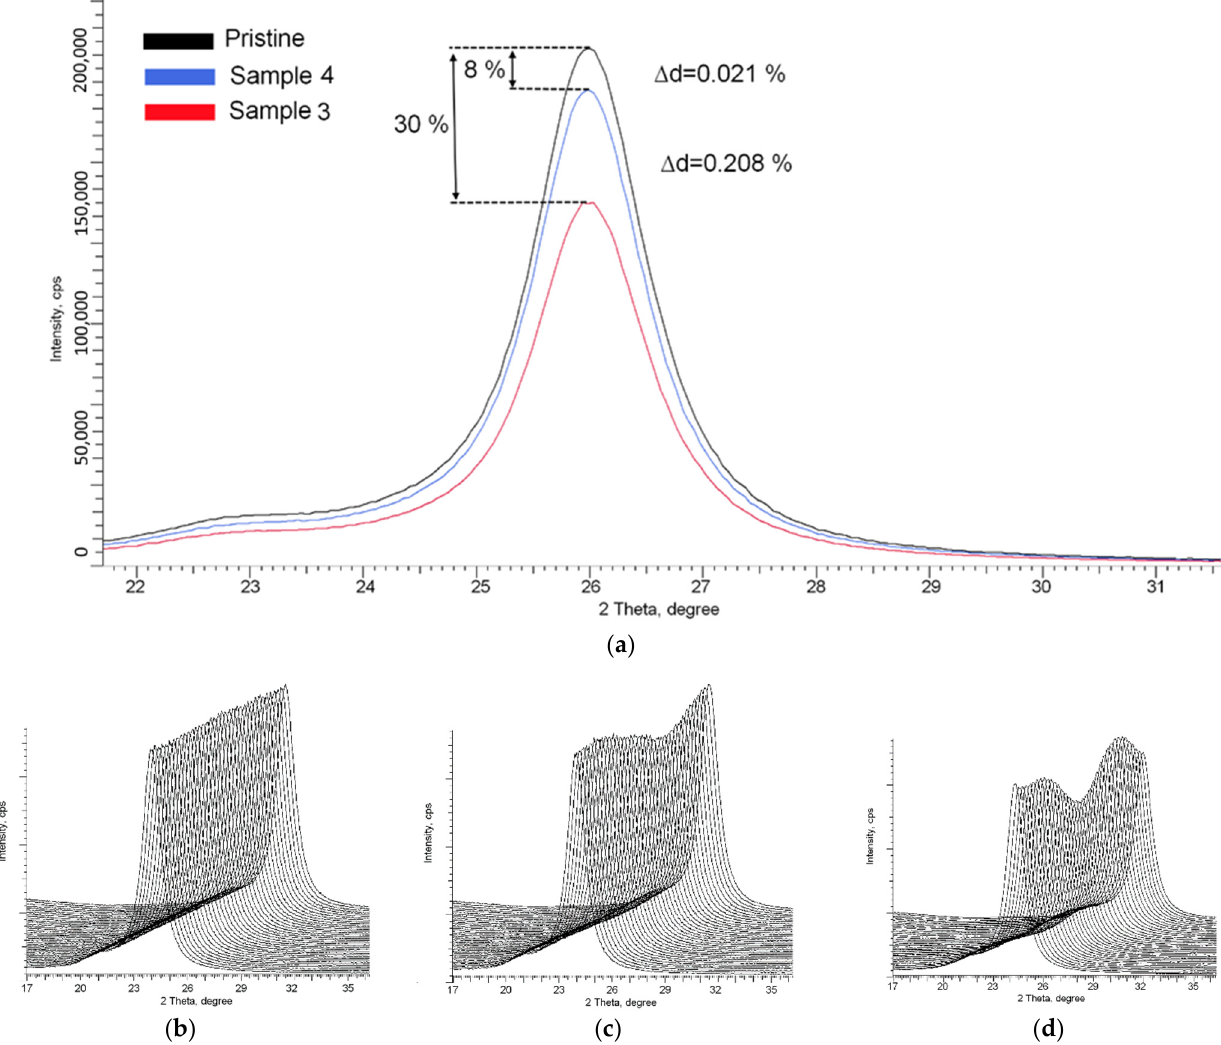
Figure 6. X-ray diffraction patterns of the studied samples of SSNTD films placed in the basement: ( a ) comparative diffraction patterns of samples after detection of α -particles; representation of X-ray diffraction patterns in survey geometry ϕ = 0–360 ◦ : ( b ) initial sample; ( c ) sample 4; ( d ) sample